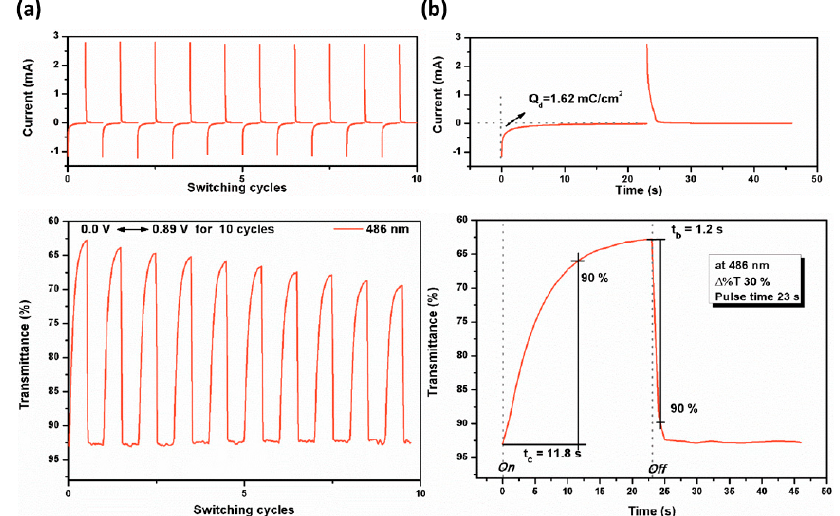
Figure 18. Potential step absorptiometry of the cast film of TPA–TPPI on the ITO-glass slide (coated area ~1 cm 2 ) (in CH 2 Cl 2 with 0.1 M Bu 4 NClO 4 as the supporting electrolyte) by appling a potential step; ( a ) optical switching at potential 0.00 V ⬄ 0.89 V (10 cycles) with a pulse width of 23 s, monitored at λ max = 486 nm; ( b ) the 1st cycle transmitance change for the TPA–TPPI thin film.